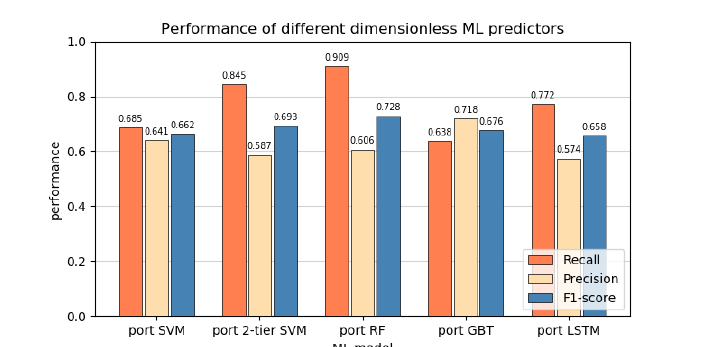
Figure 6. Recall, precision and F1-score of the different dimensionless prediction